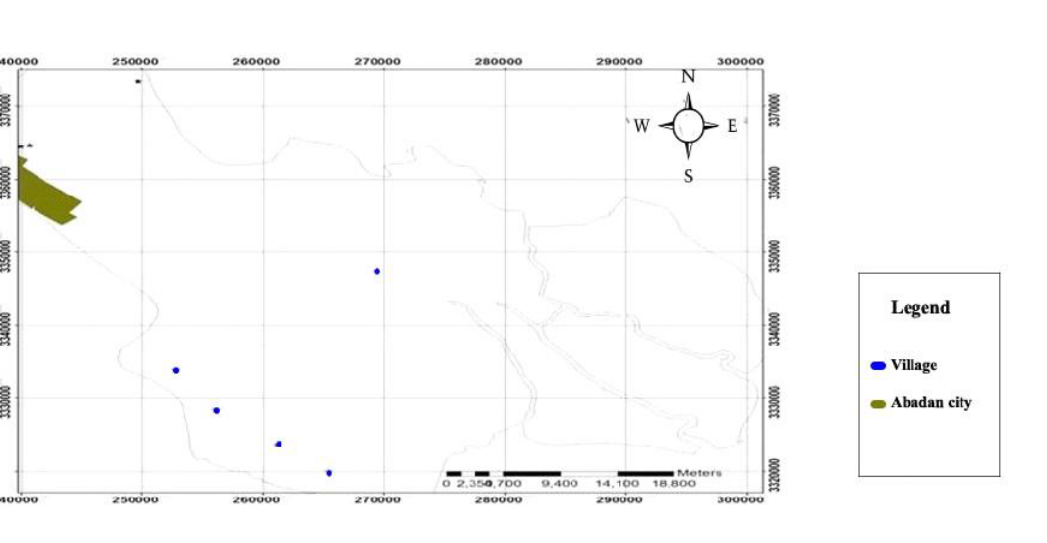
Fig. 5: Rural and urban areas